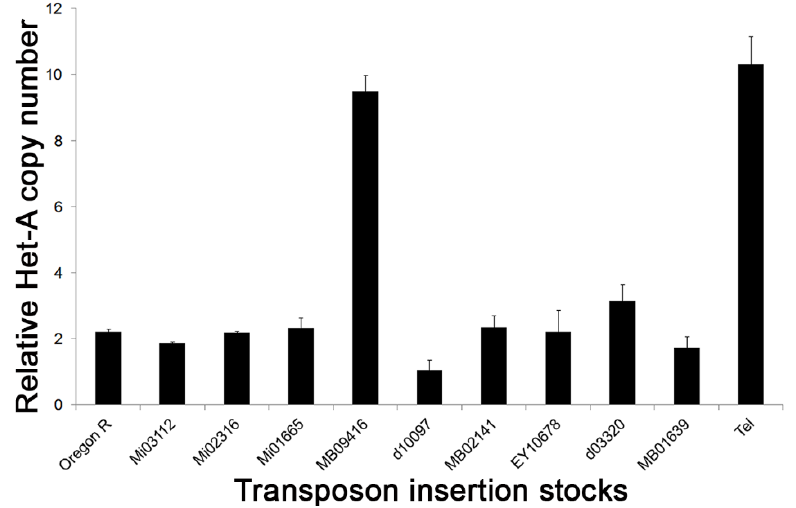
Figure 2. Telomere length in transposon insertion stocks. Q-PCR analysis of HeT-A copy number in different transposon insertion stocks used for mapping Tel 1 mutation. Error bars represent standard deviation measured from the triplicate Q-PCR results. MB09416 was not used for subsequent site- specific recombination